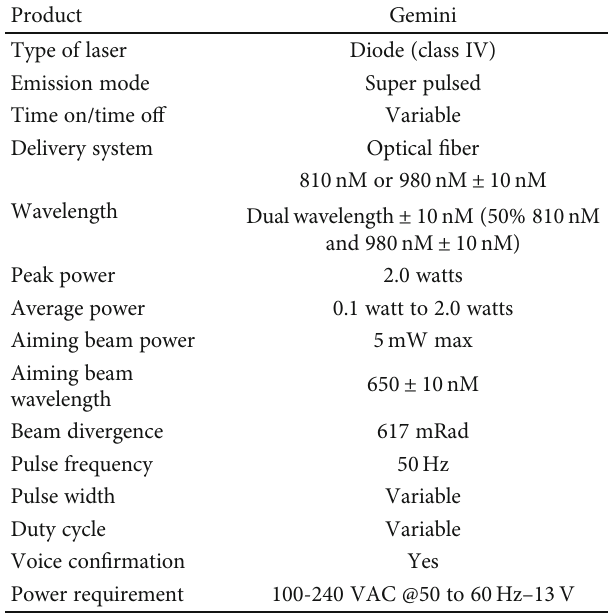
Table 1: The parameters used for the diode laser